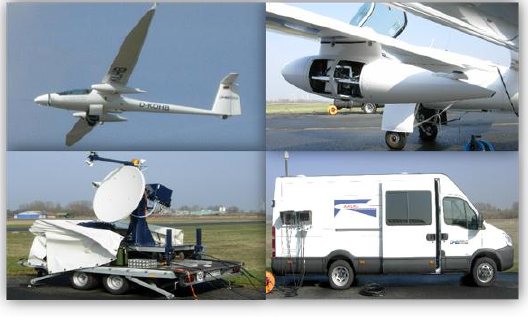
Figure 2: SELSAS-HyM Components -